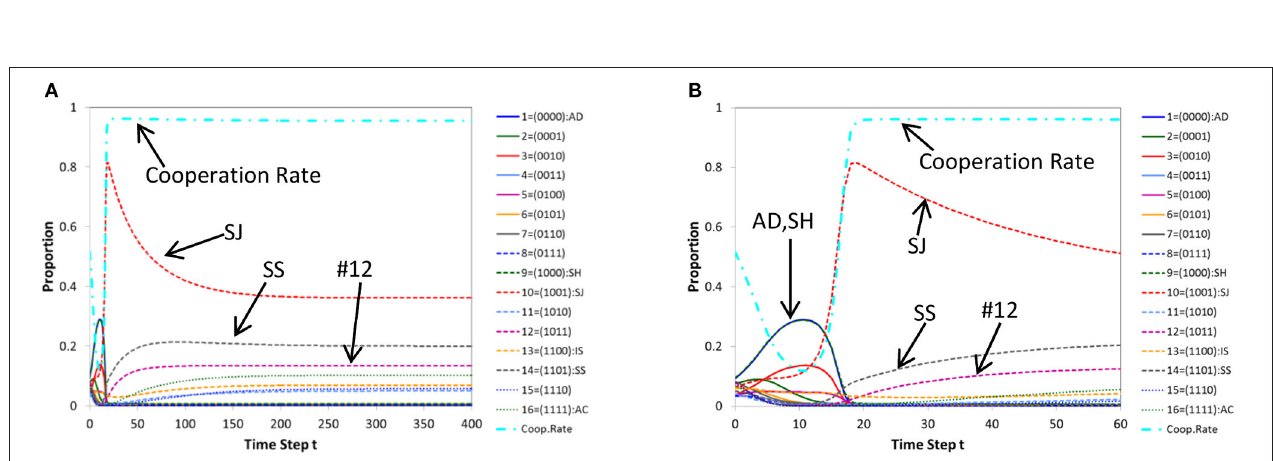
Frontiers in Physics | www.frontiersin.org